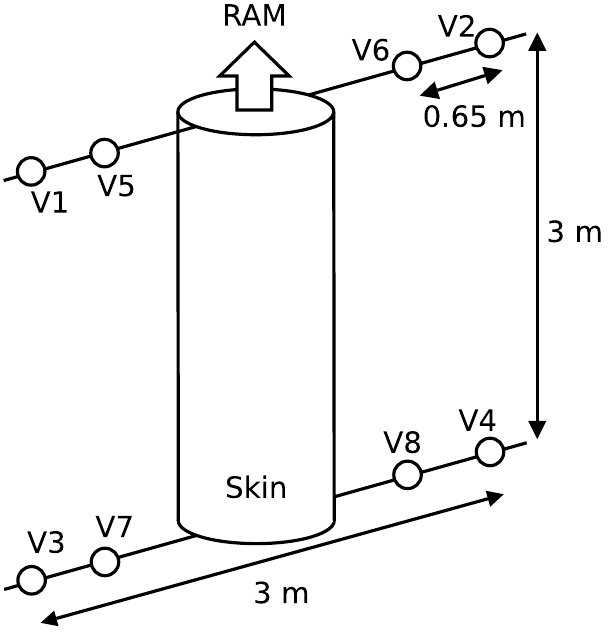
Fig. 1. MASS electric field probe arrangement. There were four booms with two probes each; two booms on the forward deck plate and two mounted on the aft deck plate. The 3 00 spherical probes were coated with graphite paint. Voltage differences between pairs of probes, as well as the probe voltage relative to the rocket skin were